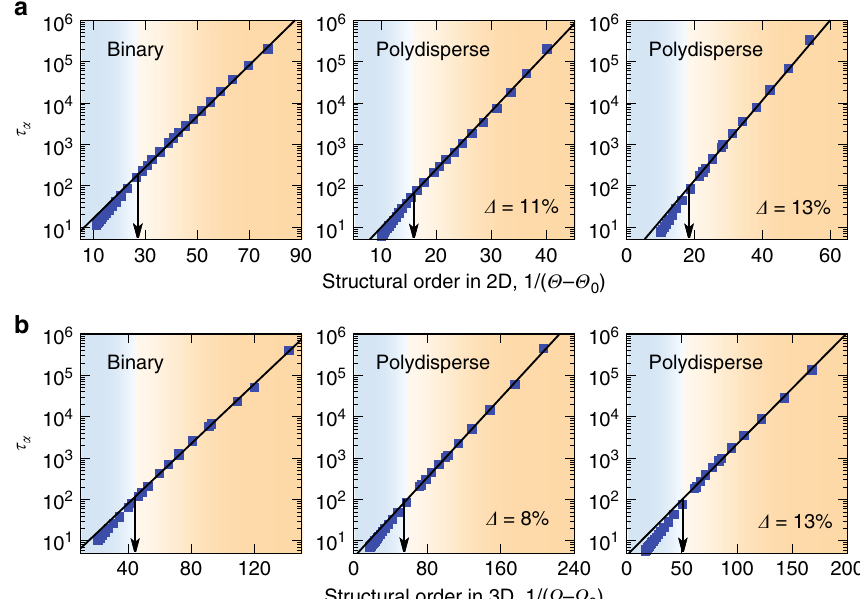
Fig. 2 Macroscopic relation between structural order and dynamics. a Structure relaxation time τ α as a function of structural order 1 = ð Θ (cid:2) Θ 0 Þ in 2D. b τ α as a function 1 = ð Ω (cid:2) Ω 0 Þ in 3D. In the (orange) supercooled regime, the solid lines are commonly the fi tting results to the data by the VFT-like relation, τ ¼ τ ½ D = ð X (cid:2) X Þ(cid:3) , with X being Θ or Ω in 2D and 3D, respectively. See Table 1 for the fi tting parameters. The vertical arrows indicate the onset α 0 exp 2 X 0 0 of structural order at T , above which the dynamics does not follow the above VFT-like on